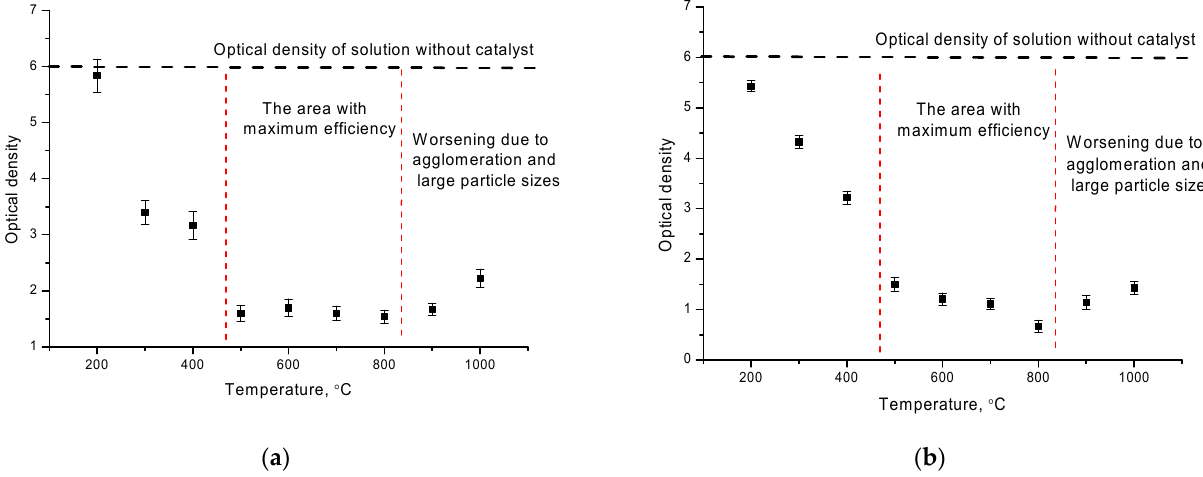
Figure 4. Diagram of the change in the optical density of the solution depending on the type of catalyst (the black dotted line indicates the optical density of the solution without a catalyst: ( a ) in the case of manganese absorption; ( b ) in the case of arsenic absorption.